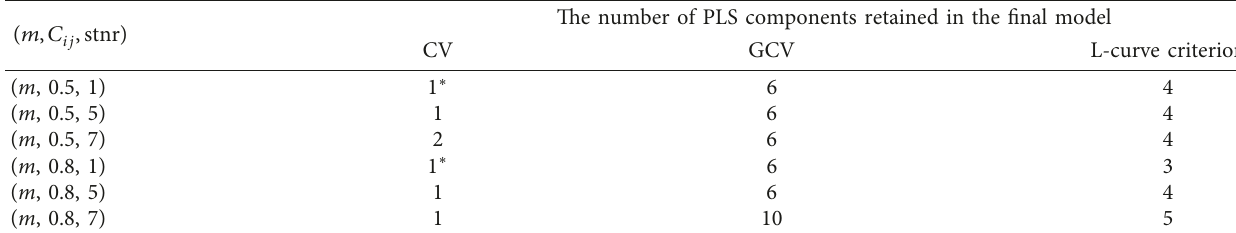
Table 5: The result of comparison between cross validation (CV), generalized cross validation (GCV), and L-curve criterion in PLS regression in terms of the number of components retained in the final model.